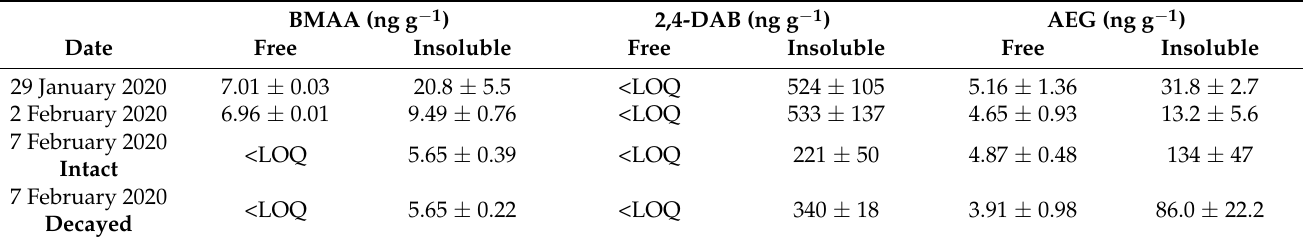
Table 1. Toxin concentrations ± standard deviation ( n = 3) in environmental samples. <LOQ denotes detections below the limit of